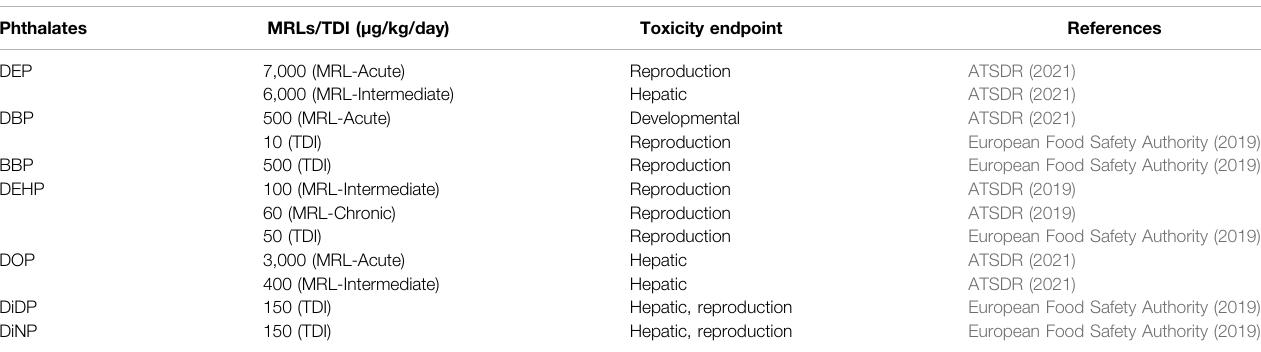
TABLE 5 | Recommended toxicity uptake limits of some PEs in